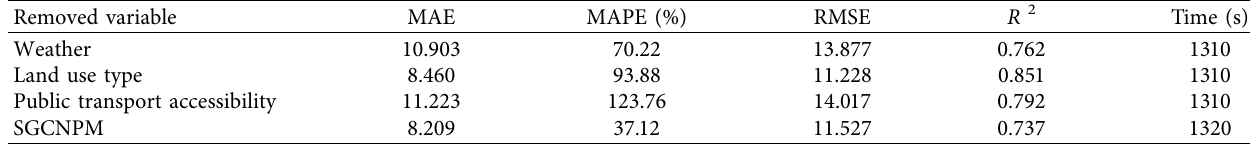
Table 4: Result comparison of removing any